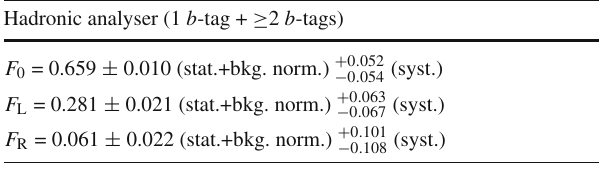
Table 3 Measured W boson helicity fractions for the hadronic analyser including the statistical uncertainty from the fit and the background normalisation as well as the systematic uncertainty Hadronic analyser (1 b -tag + ≥ 2 b -tags)